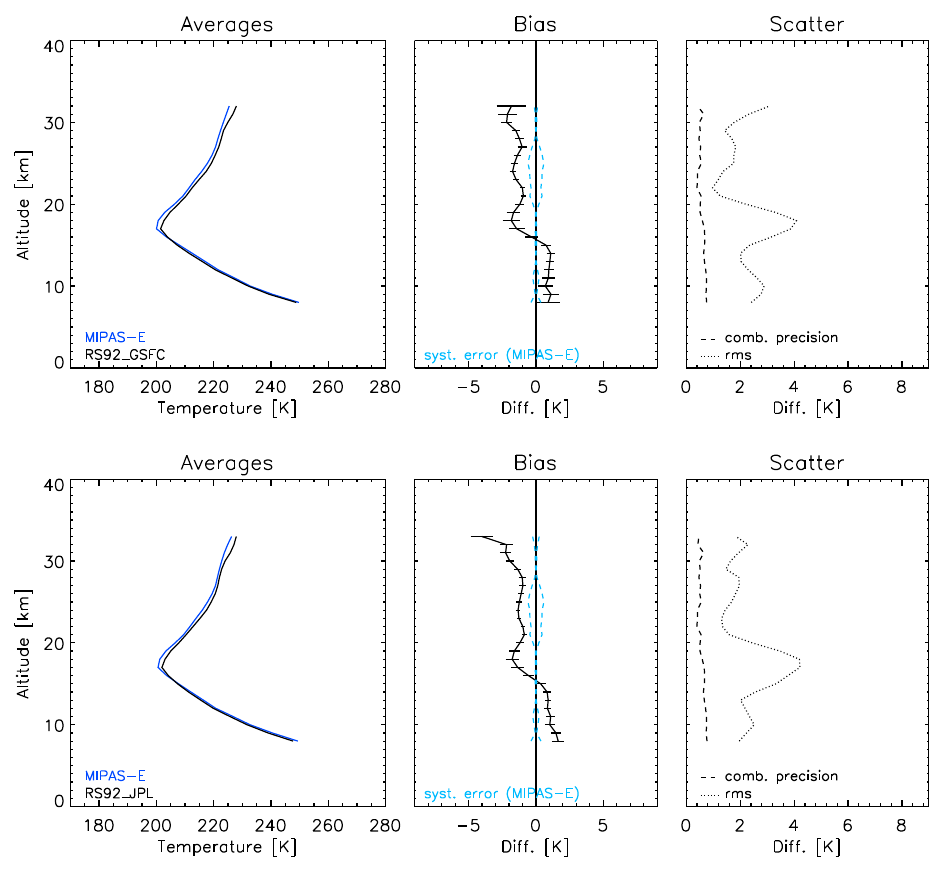
Fig. 6. Same as Fig. 2, but for RS92 GSFC (top) and RS92 JPL (bottom) radiosonde temperature profiles. For a more detailed description see Fig. 2.